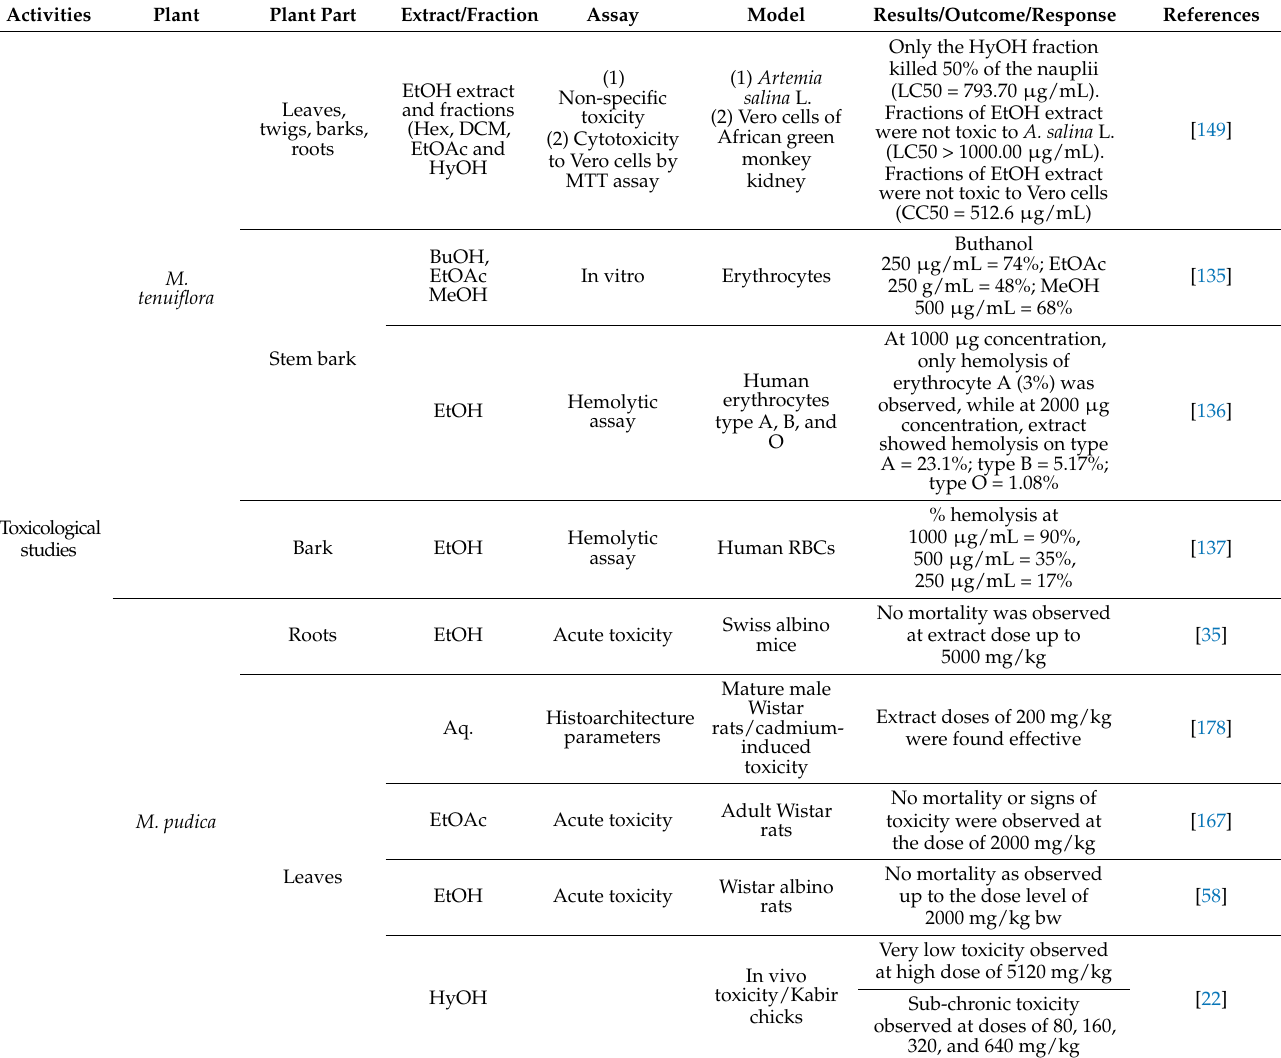
Table 3. Toxicological studies of the genus Mimosa regarding hemolysis, antimutagenic, genotoxic, and teratogenic effects. Activities Plant Model